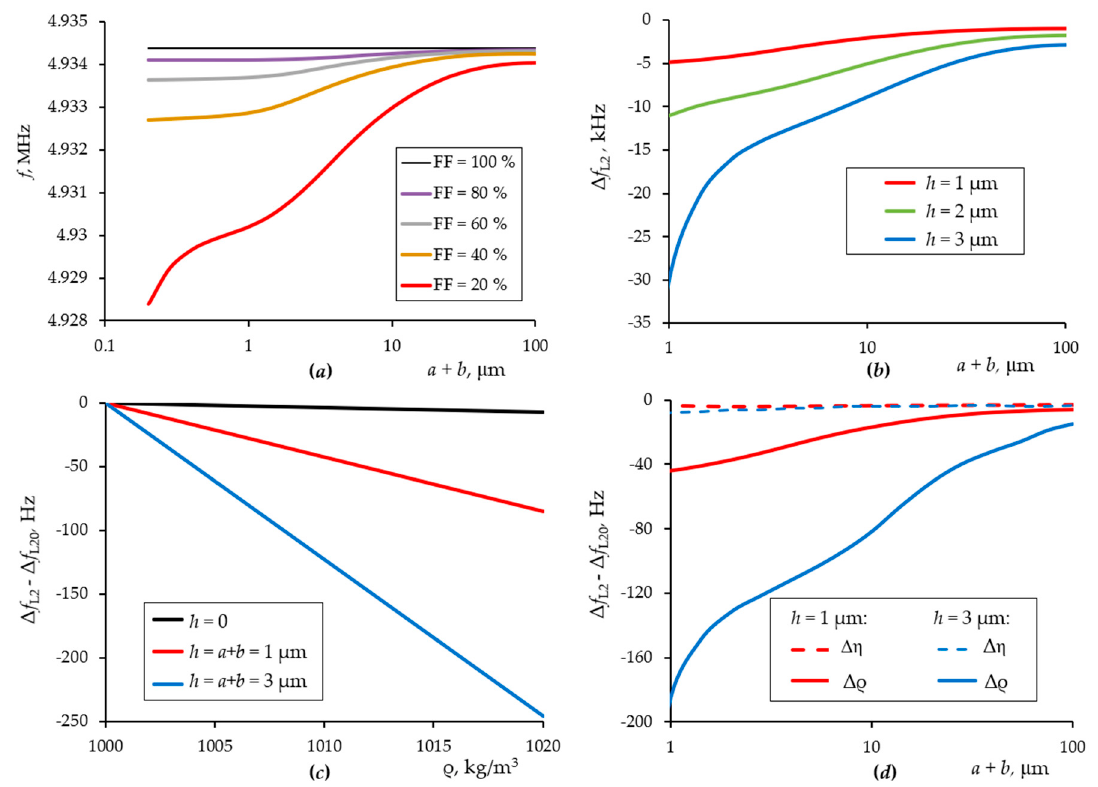
Figure 3. Resonant frequency of a quartz crystal sensor depending on the method of structuring its surface at various filling factors and an average height of 200 nm ( a ); shift of the resonant frequency of a quartz resonator, depending on the method of structuring its surface at a filling factor of 20 % and different block heights ( b ); resonator frequency shift depending on liquid density for different heights of structural elements ( c ); frequency shift of a quartz resonator with structured surface elements of 1 and 3 μ m height with a change in the liquid density and viscosity of 1 % ( d ). Subscript “0” means original liquid parameters.